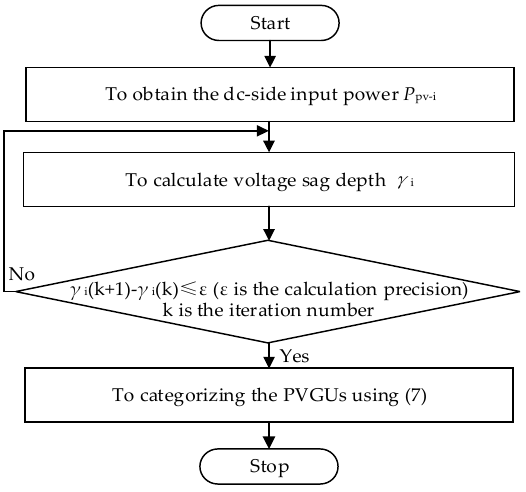
Figure 2. Procedure for dividing multiple PVGUs into two groups.